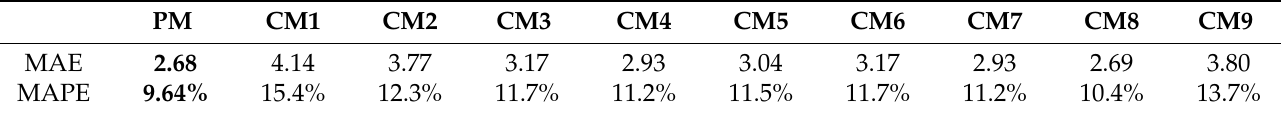
Table 3. Mean absolute error (MAE) and mean absolute percent error (MAPE) of prediction results obtained by the proposed method and the comparative